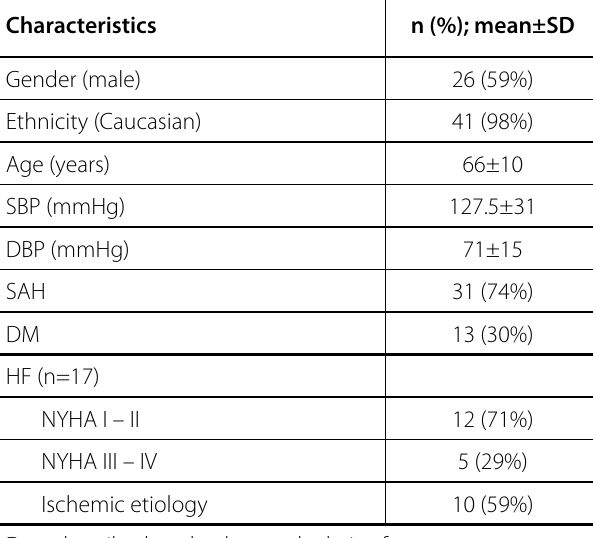
Table 1 . Characteristics of the study population (n=43). Characteristics